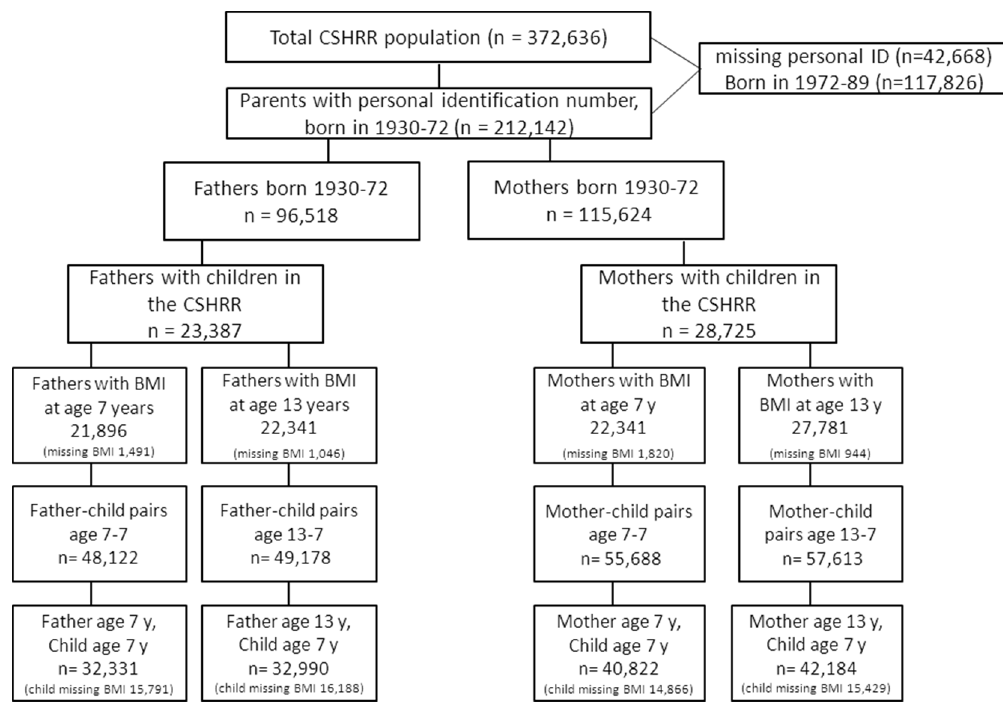
Figure 1. Flow-chart of the study population.